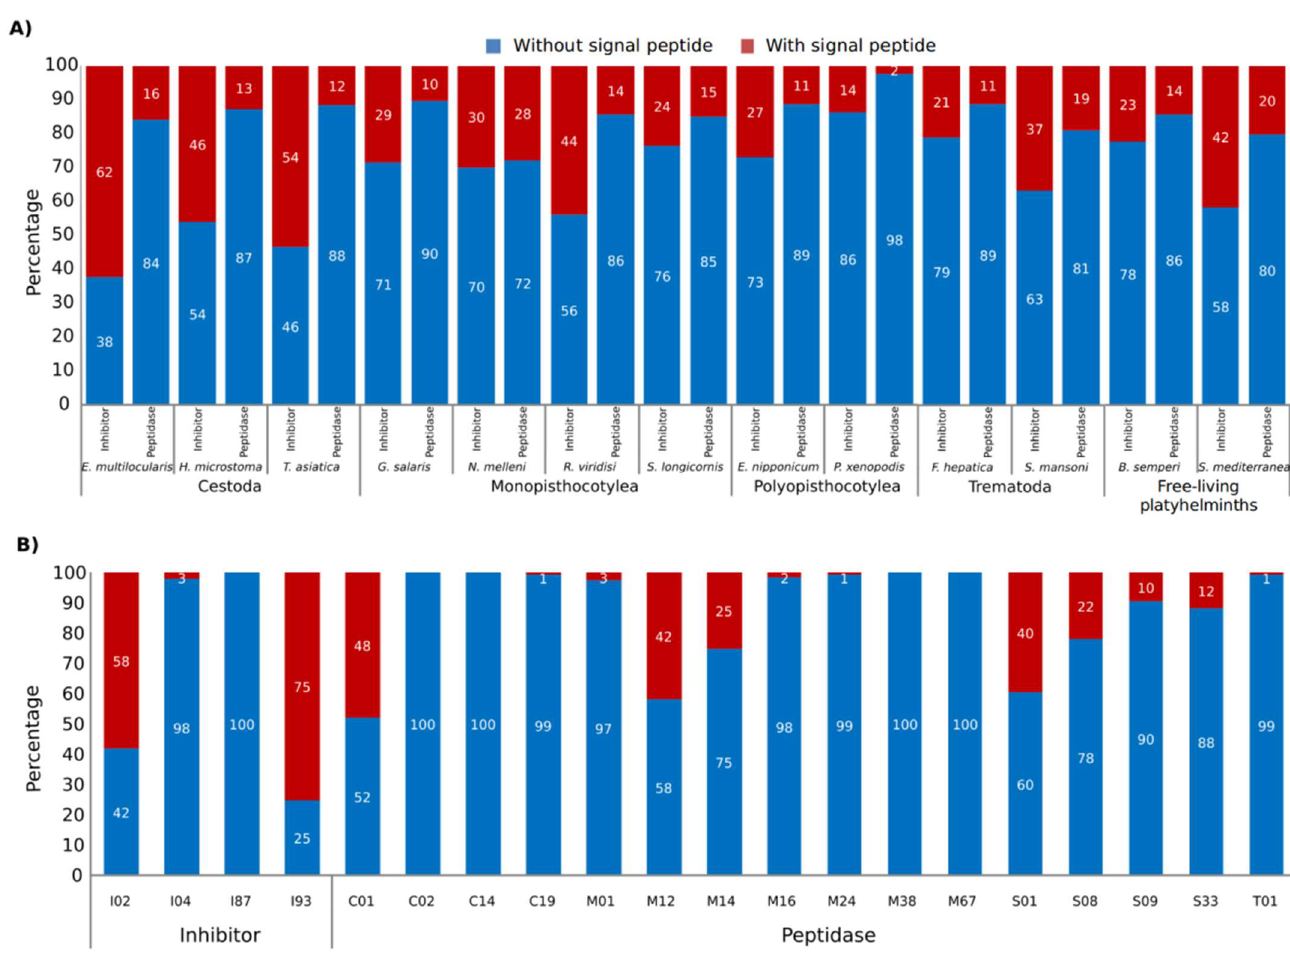
Figure 3. Peptidases and inhibitors with predicted signal peptides in the platyhelminth species analysed. ( A ) The proportion of peptidases and inhibitors with/without predicted signal peptides for secretion. ( B ) Proportion of secreted protein in the top 20 most abundant peptidase and inhibitor families.